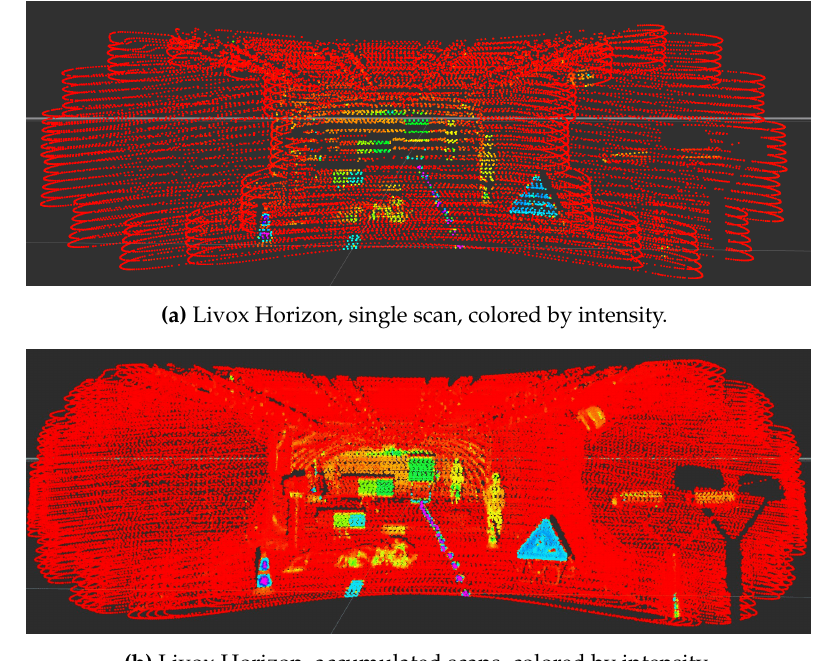
Figure 5. Captures of pointclouds from Livox